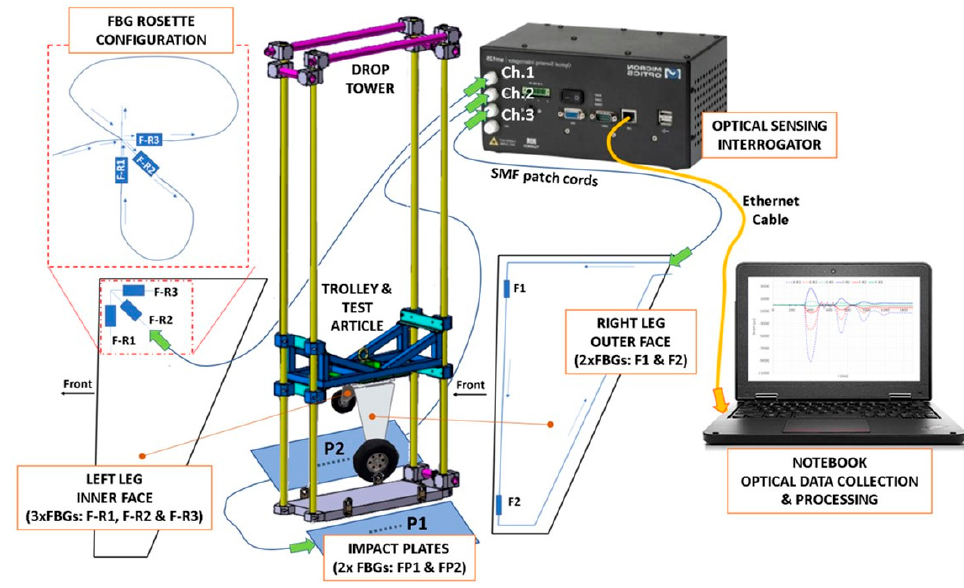
Figure 7. FBG-based hard landing monitoring system test rig.